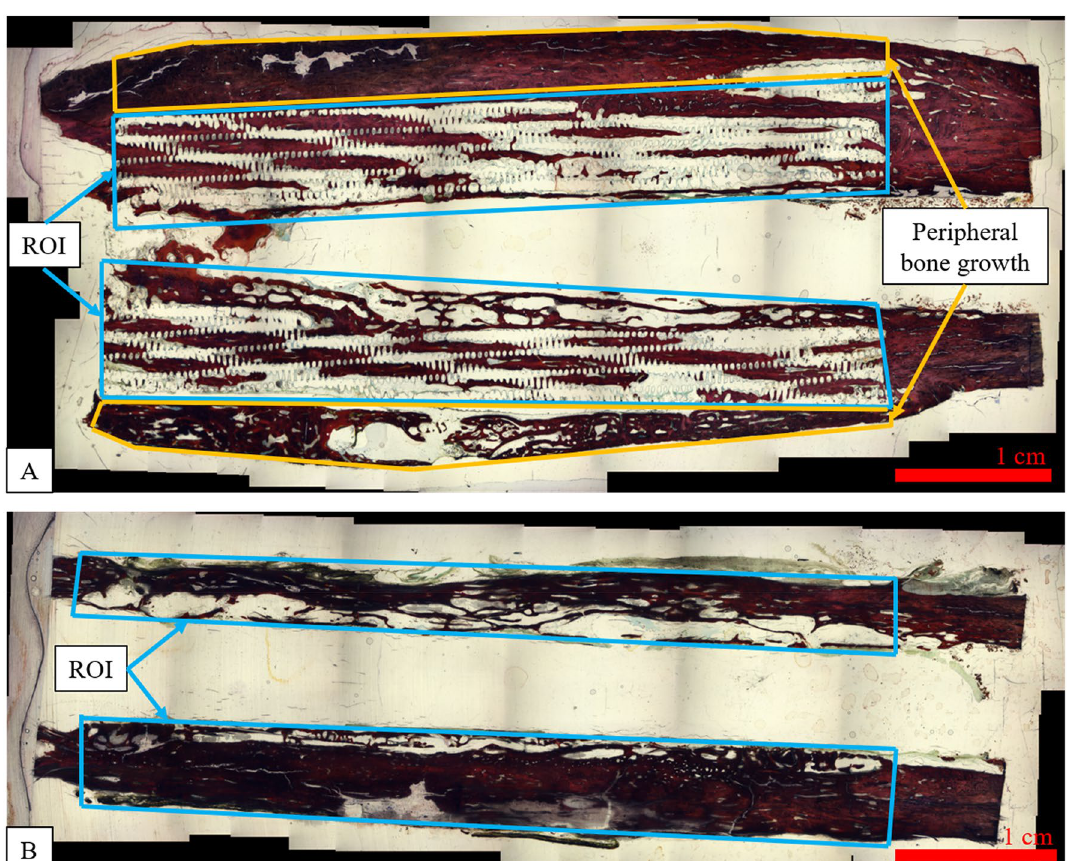
Figure 3. Histomorphometry evaluations of bone, scaffold, and soft tissue area fraction were performed within the ROI (bounded by blue). Example ROIs are shown for ( A ) the scaffold treatment group, in which the ROI is bounded by the scaffold perimeter, and ( B ) the control treatment group, in which the ROI is bounded by the new bone growth in the 5 cm defect region. Additionally, for the scaffold treatments, the area of peripheral bone growth was measured (bounded by yellow). Images were generated by ImagePro Premier software, version 9.3 (Media Cybernetics, https:// www. media cy. com/ image propl